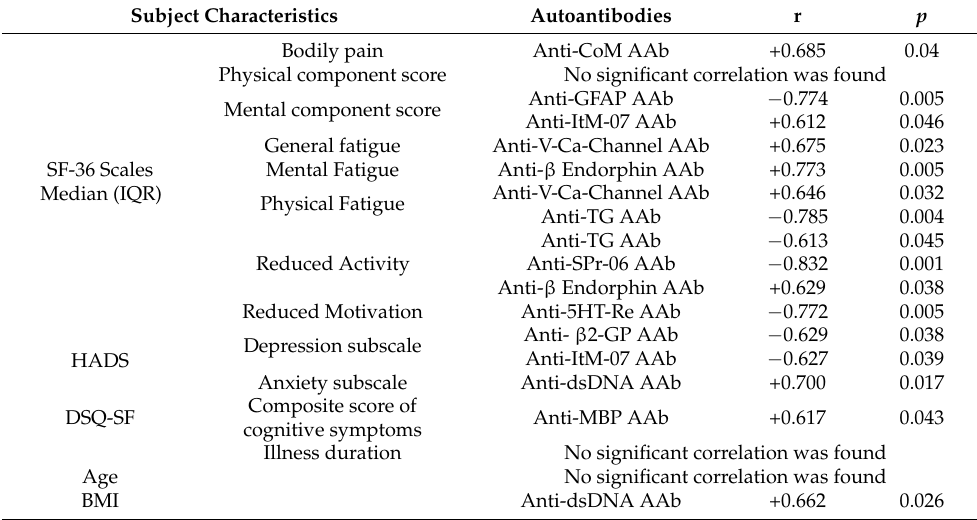
Table 6. Clinical correlations of the absolute AAb deviations from AIR in the group of patients suffering from ME/CFS with comorbid FM. (Spearman correlation coefficient r and p